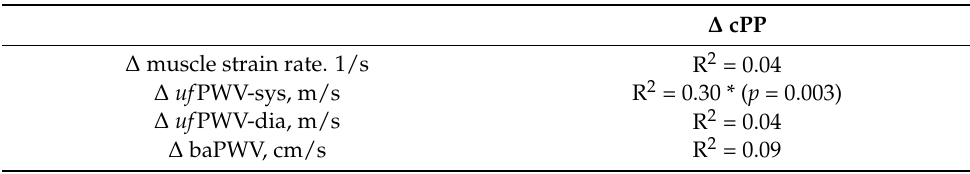
Table 4. Simple linear regression analysis of increased cPP in response to bicep curl resistance exercise (two exercise sessions